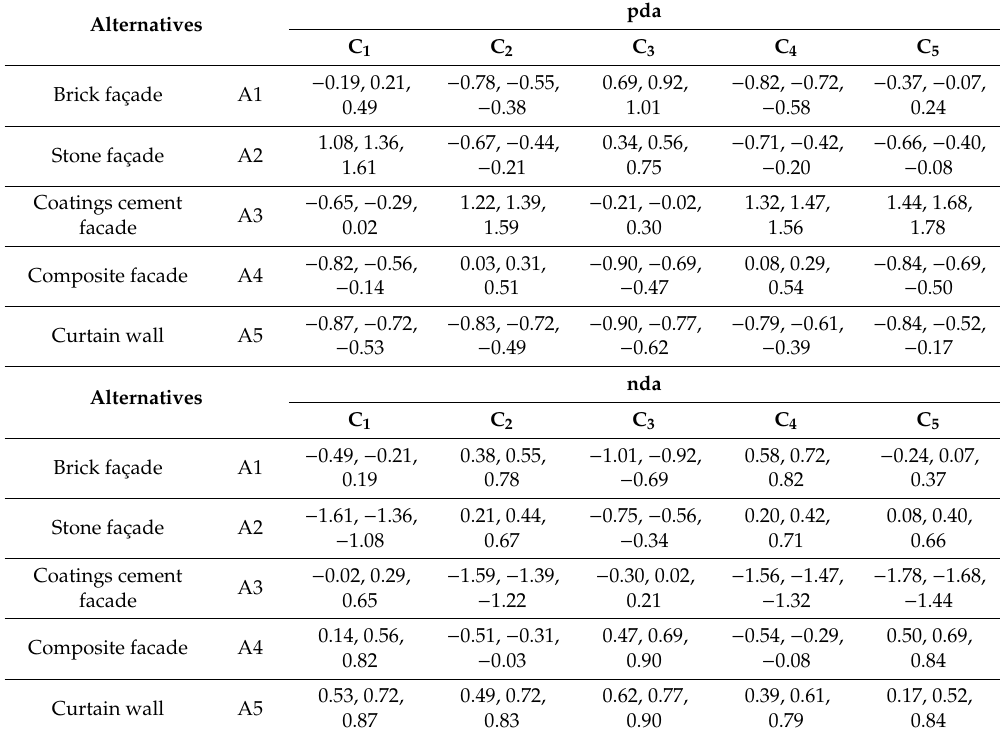
Table 9. Negative distance from average (nda) and positive distance from average